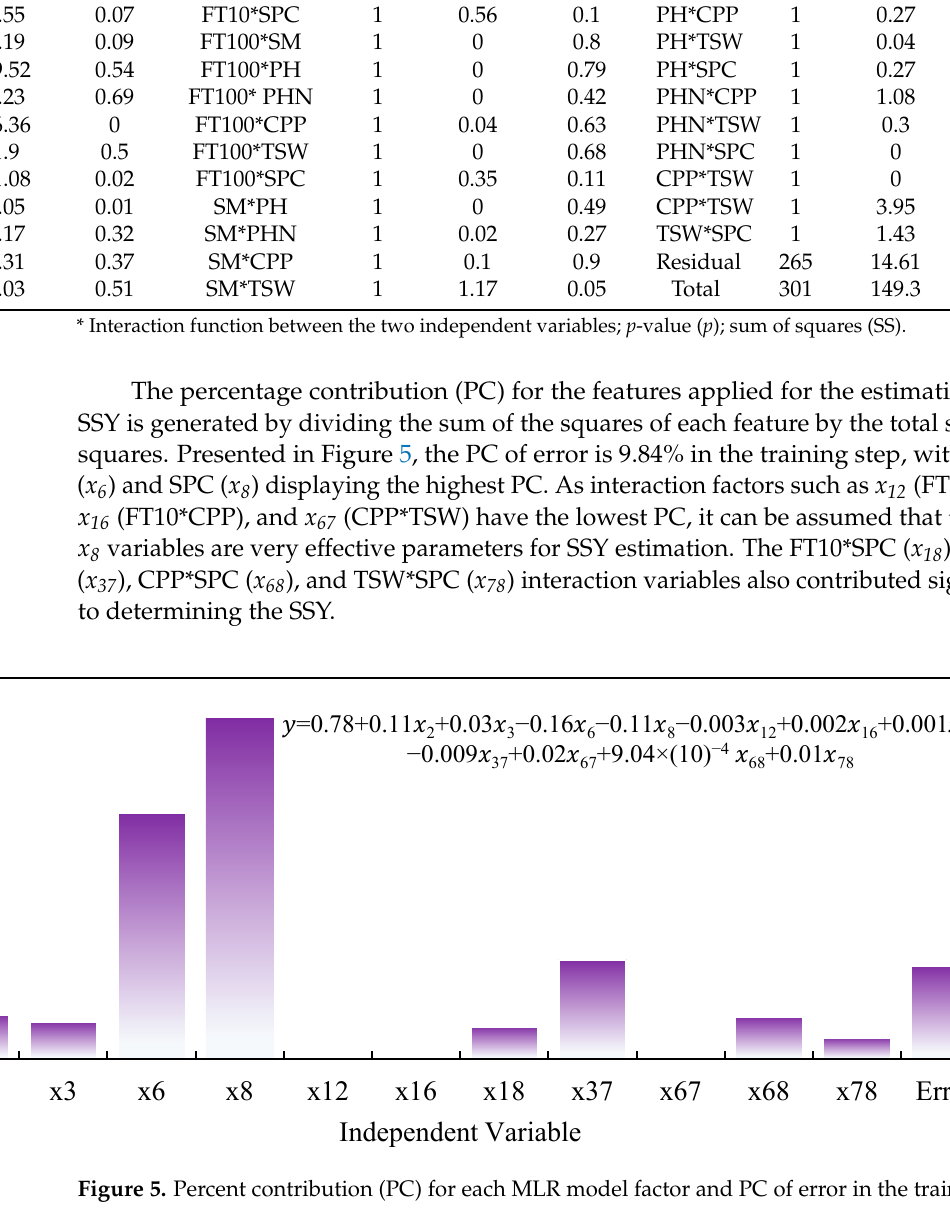
Figure 5. Percent contribution (PC) for each MLR model factor and PC of error in the training phase.